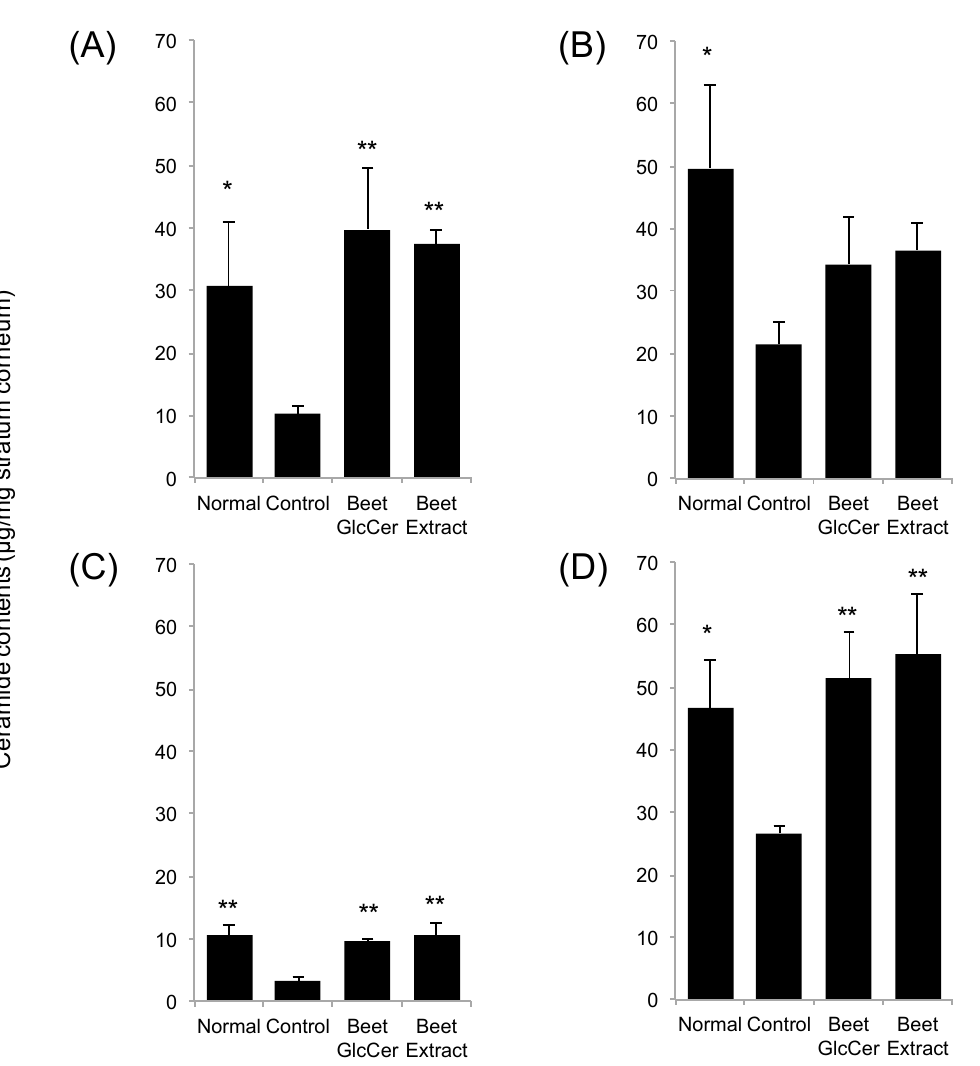
Figure 3. Ceramide contents in stratum corneum in UVB-irradiated (200 mJ/cm 2 ) mice after oral administration of beet GlcCer or beet extract. Ceramide NS ( A ); NP ( B ); AS ( C ) and AP ( D ); respectively. Values are given as means and standard deviation ( n = 3). * p < 0.05, ** p < 0.01 vs. control group, Tukey’s post-hoc multiple comparison test.